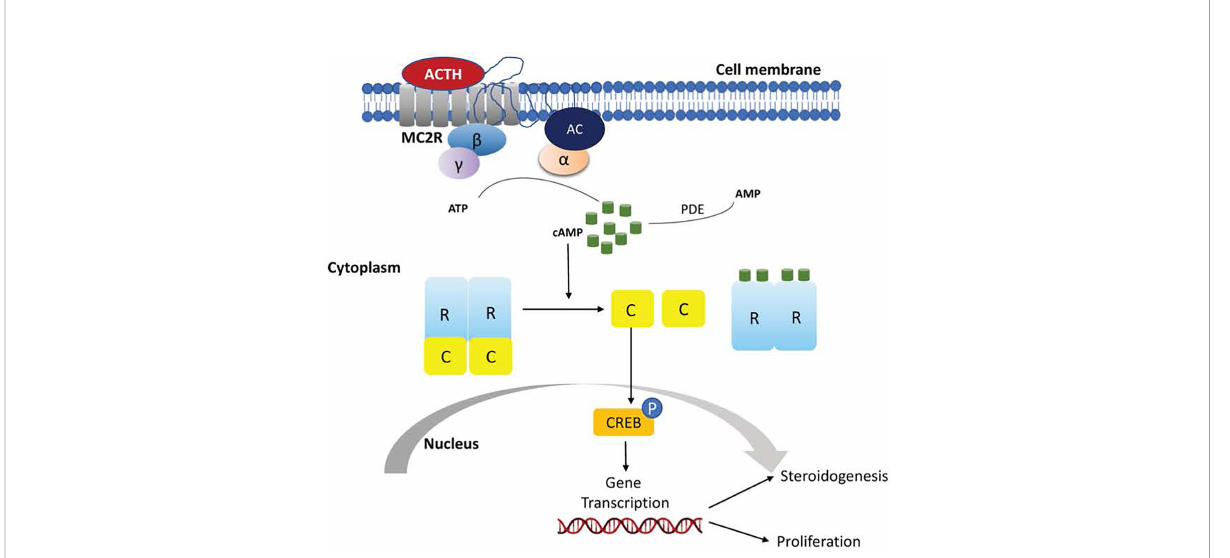
FIGURE 1 Schematic representation of activation of the cyclic adenosine monophosphate (cAMP) signaling pathway in normal adrenocortical